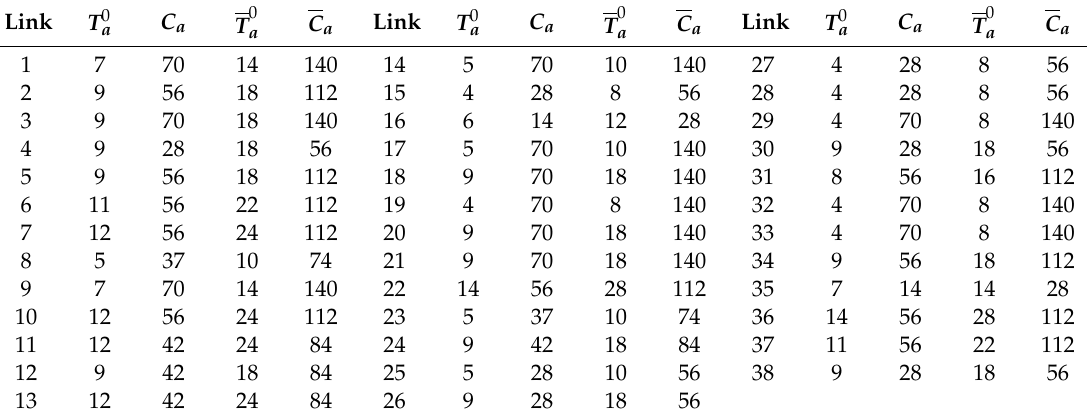
Figure 4. The Nguyen–Dupuis network. Table 6. Link parameters of the Nguyen–Dupuis network.